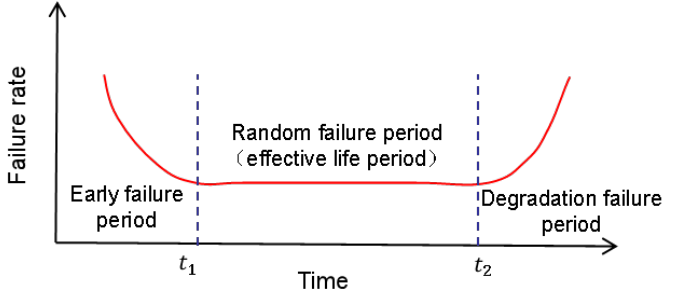
Figure 4. Bathtub curve of the failure rate. Table 3. Values for element failure rates of the box-part finishing FMS.